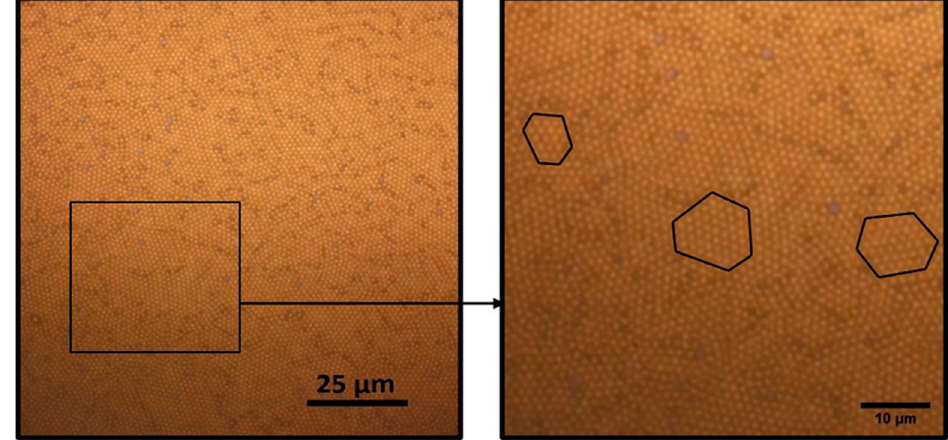
Figure 11. Self-assembly of spin coated 1.31 μ m diameter MSNs to hexagonal monolayer arrays.